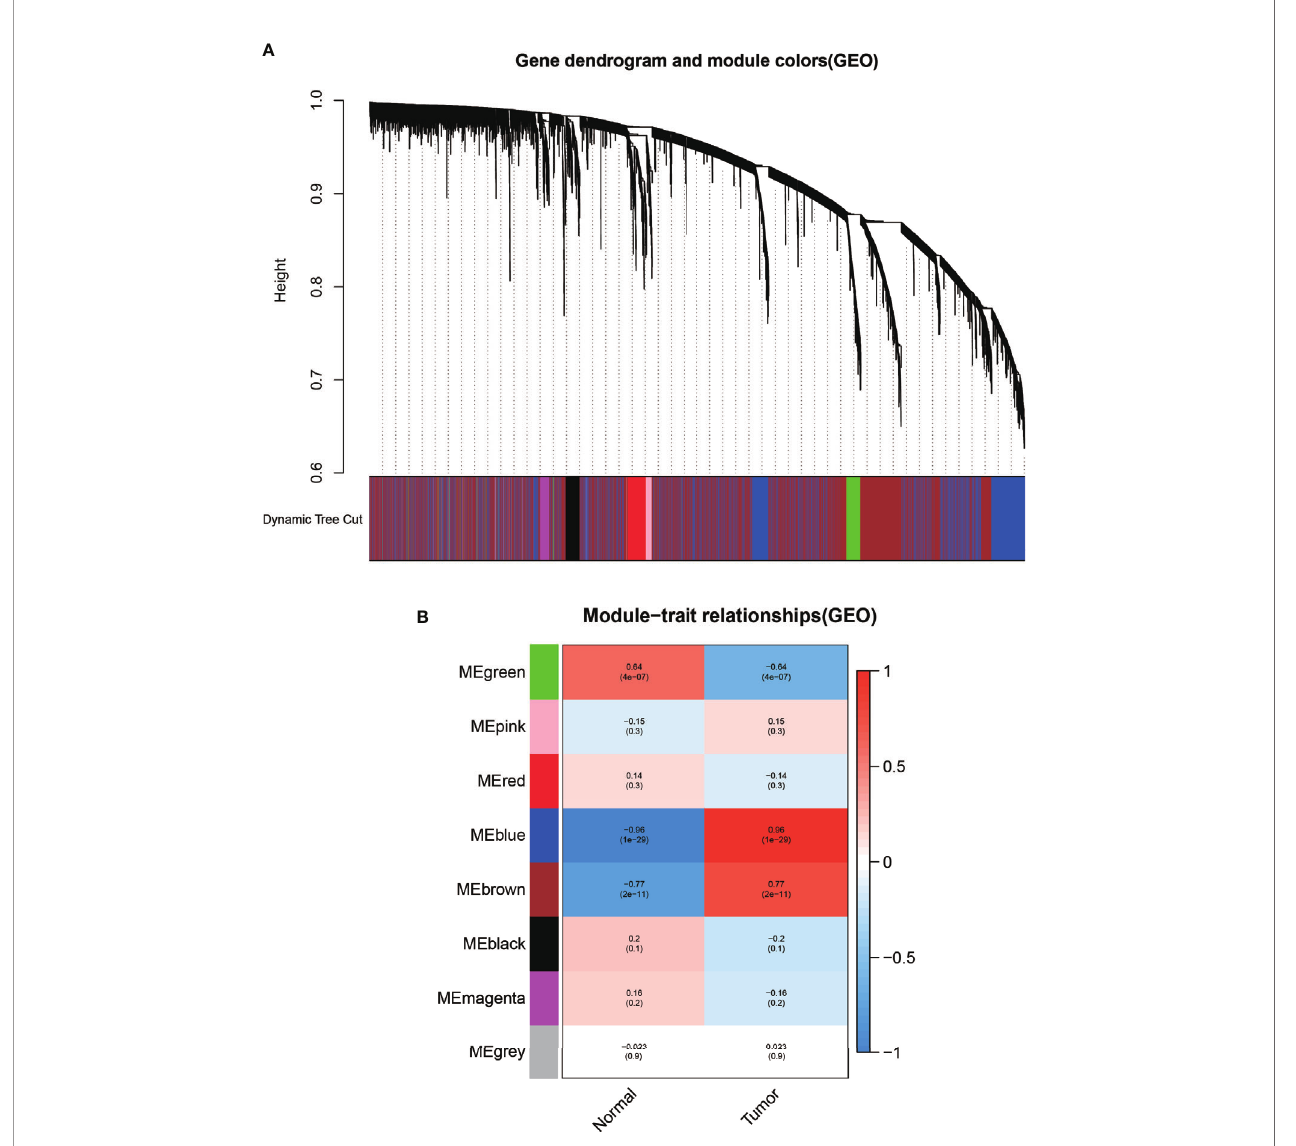
FIGURE 4 | Identi fi cation of modules related to clinical information in the GSE3189 database. (A) Clustered tree diagram of co-expression network modules sorted by gene-level clustering of matrices obtained by Equation 1-TOM. Each color represents a different co-expressed gene. (B) Relationship diagram of the features of the modules. Each row corresponds to a color module, and each column corresponds to a clinical feature (normal and cancer). Each cell contains the correlation and P-value of the corresponding